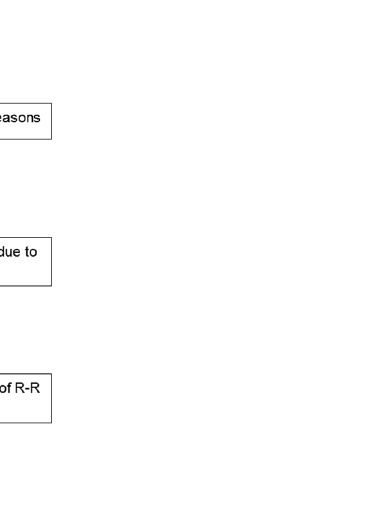
Figure 1. Flowchart sample loss during the